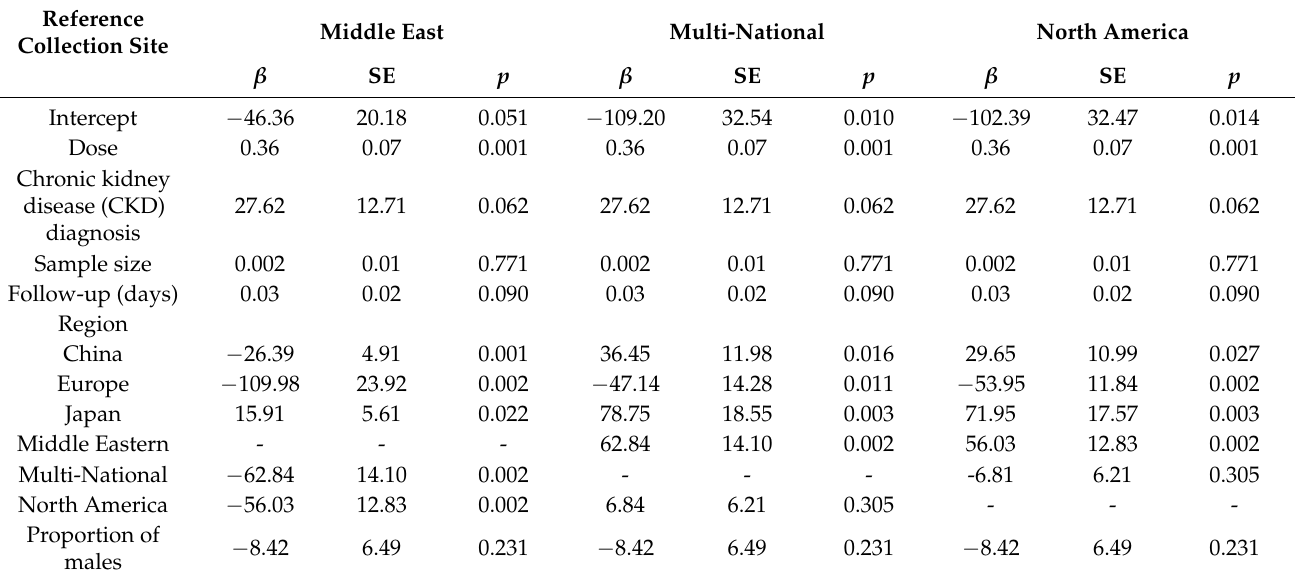
Table 2. Covariate model for allopurinol and post-hoc analyses based on data collection site [29–63].